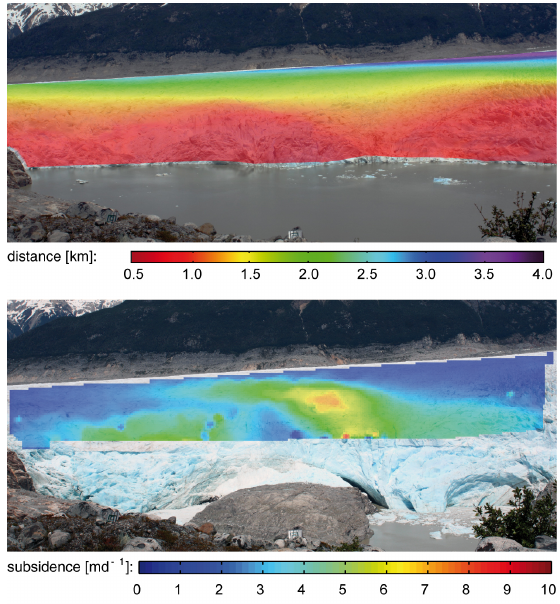
Figure 7. Distance between camera and glacier surface (top). Scaled subsidence of the glacier surface